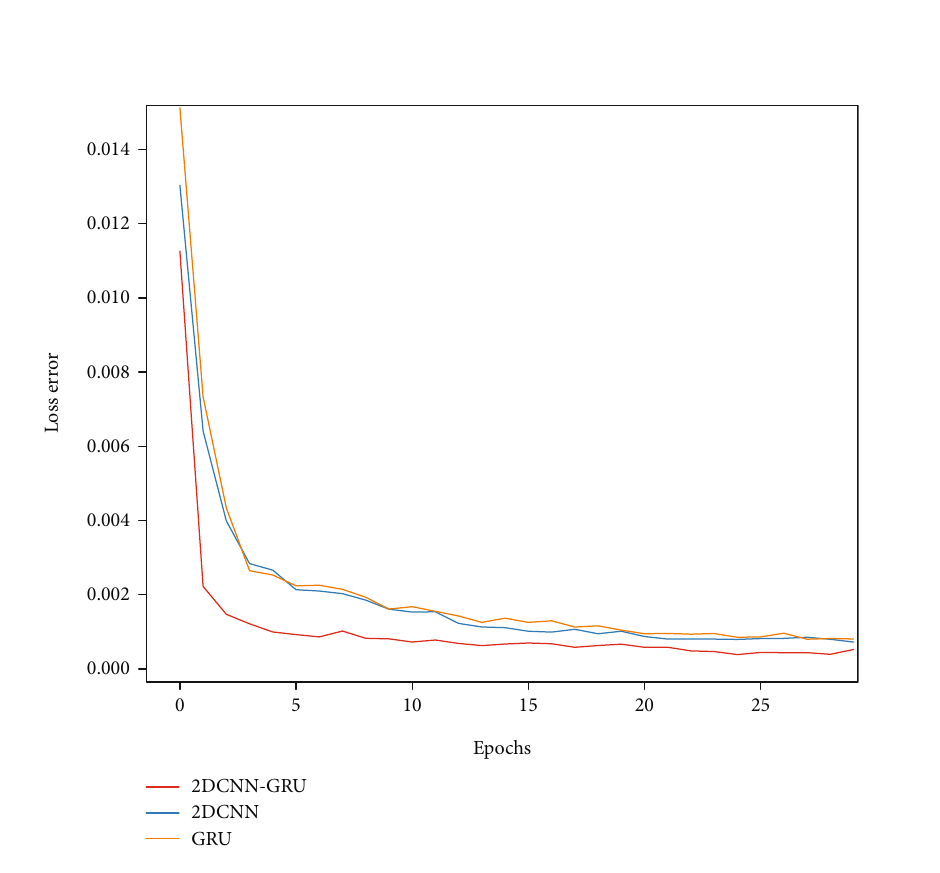
Figure 8: Loss error curves of 2DCNN-GRU, 2DCNN, and GRU